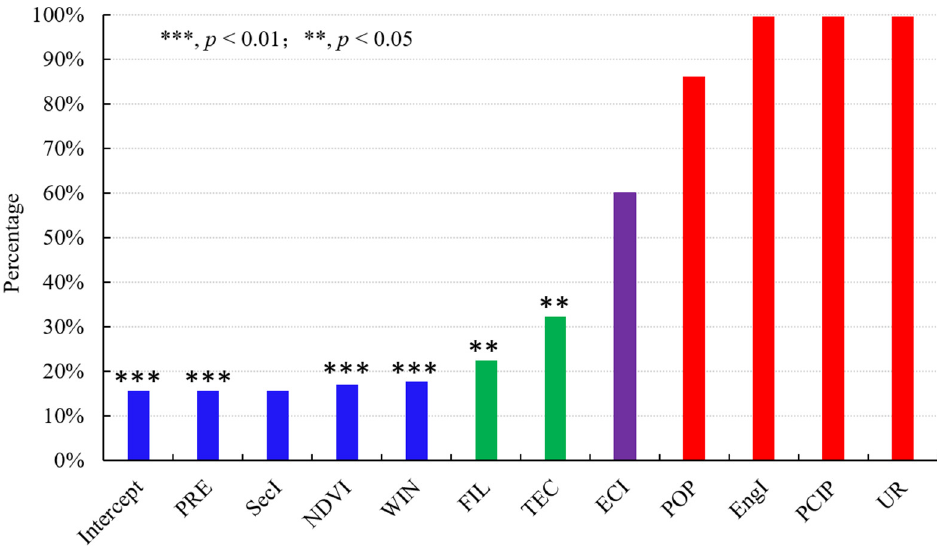
Figure 3. The bandwidth percentage for each impact factor in the total number of samples. The blue bar represents the small regional scale, the green bar represents the medium regional scale, the purple bar represents the large regional scale, and the red bar represents the global scale. *** denotes 99% confidence that passes the Monte Carlo significance test, ** denotes 95%. From left to right on the X axis, the bandwidth is increasing.